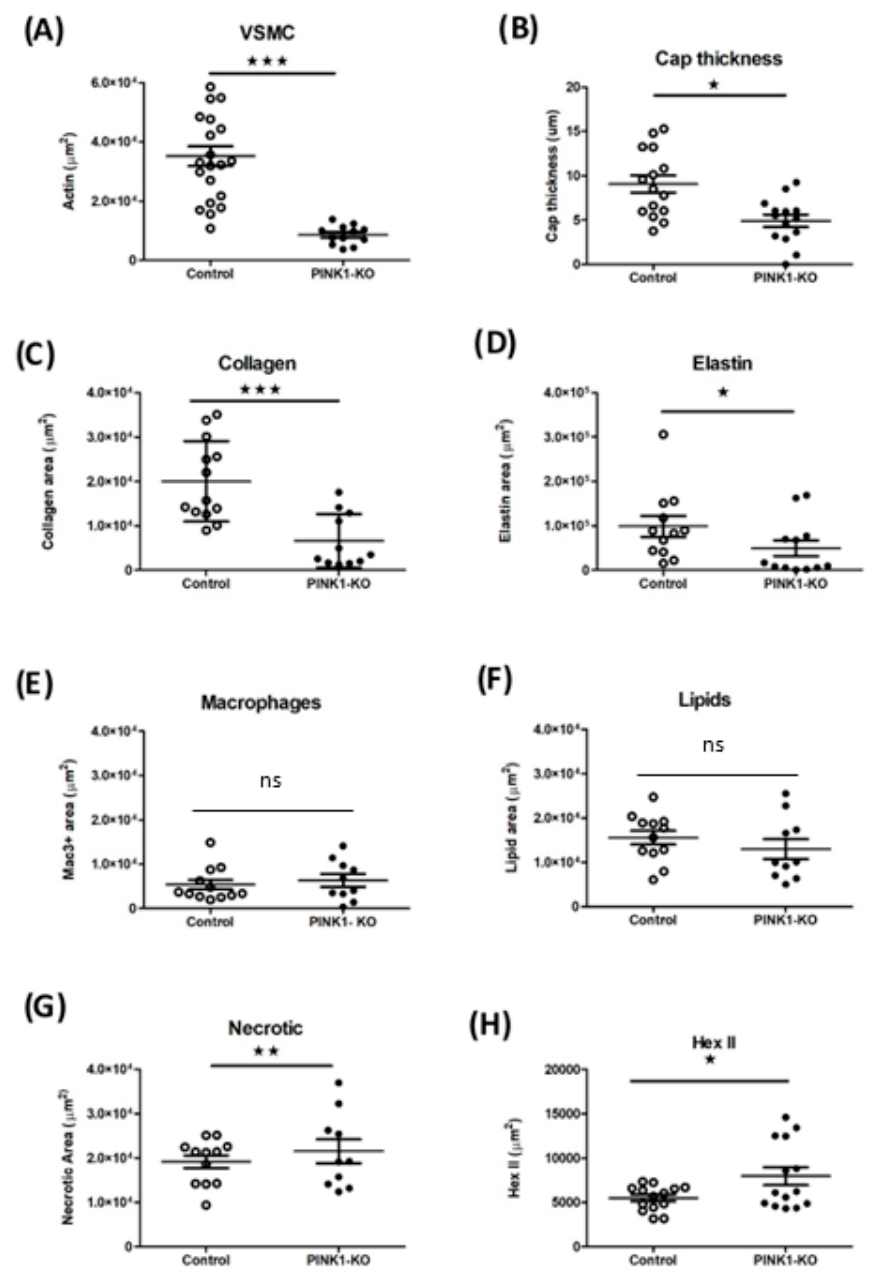
Figure 4. Pink1-KO ApoE − / − mice have reduced VSMCs and extracellular plaque components. Quan- tification of plaque regions by immunohistochemistry for ( A ) VSMC (a-SMA+), ( B ) cap thickness, ( C ) extracellular collagen (sirius red), ( D ) elastin abundance (Verhoefff Van Gieson) stain, ( E ) mac- rophages (mac3+), ( F ) lipid void area, ( G ) necrotic area areas, and ( H ) hexokinase 2 abundance. Re- gions of stained plaque (n = 9 – 15). (ns—non significant), Student t -test. * p ≤ 0.05, ** p ≤ 0.01*** p ≤ 0.001 vs. control.